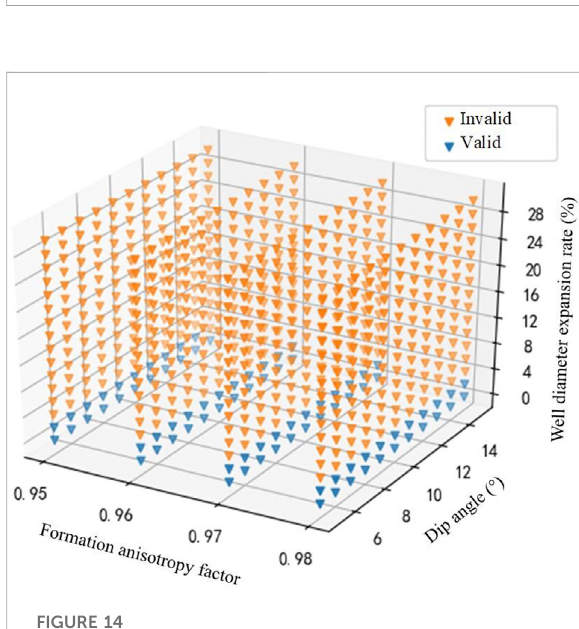
FIGURE 11 Bent-housing motor BHA build rates with different diameter expansion.